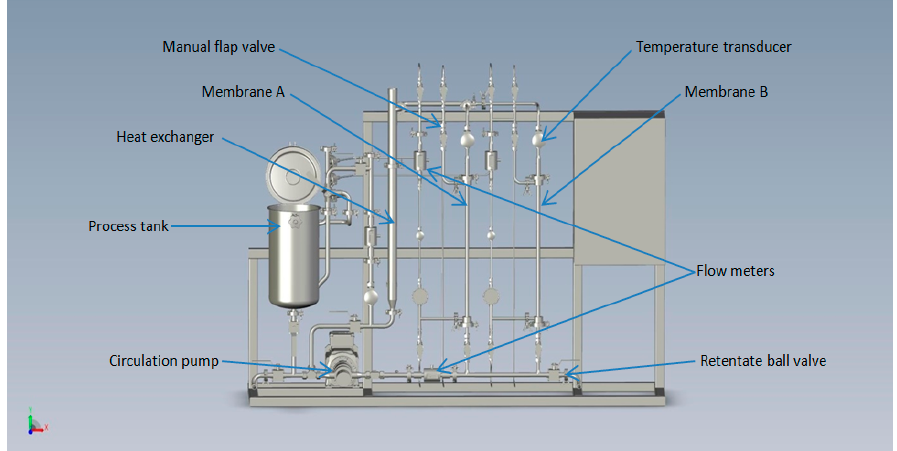
Figure 6. Scheme of the process in a membrane plant.